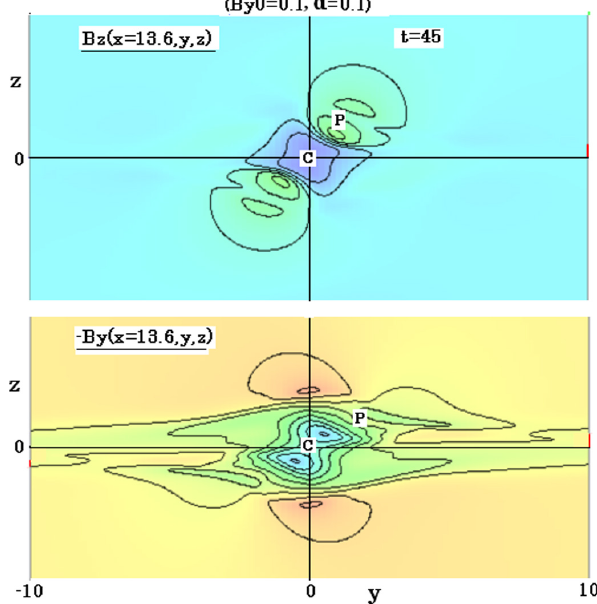
Fig. 10. Distributions of B z and − B y (contour interval of 0.1) at t = 45 for the case of B y0 = 0 . 1 and α = 0 . 1 in the cross section at x = 13 . 6, where the regions P and C are